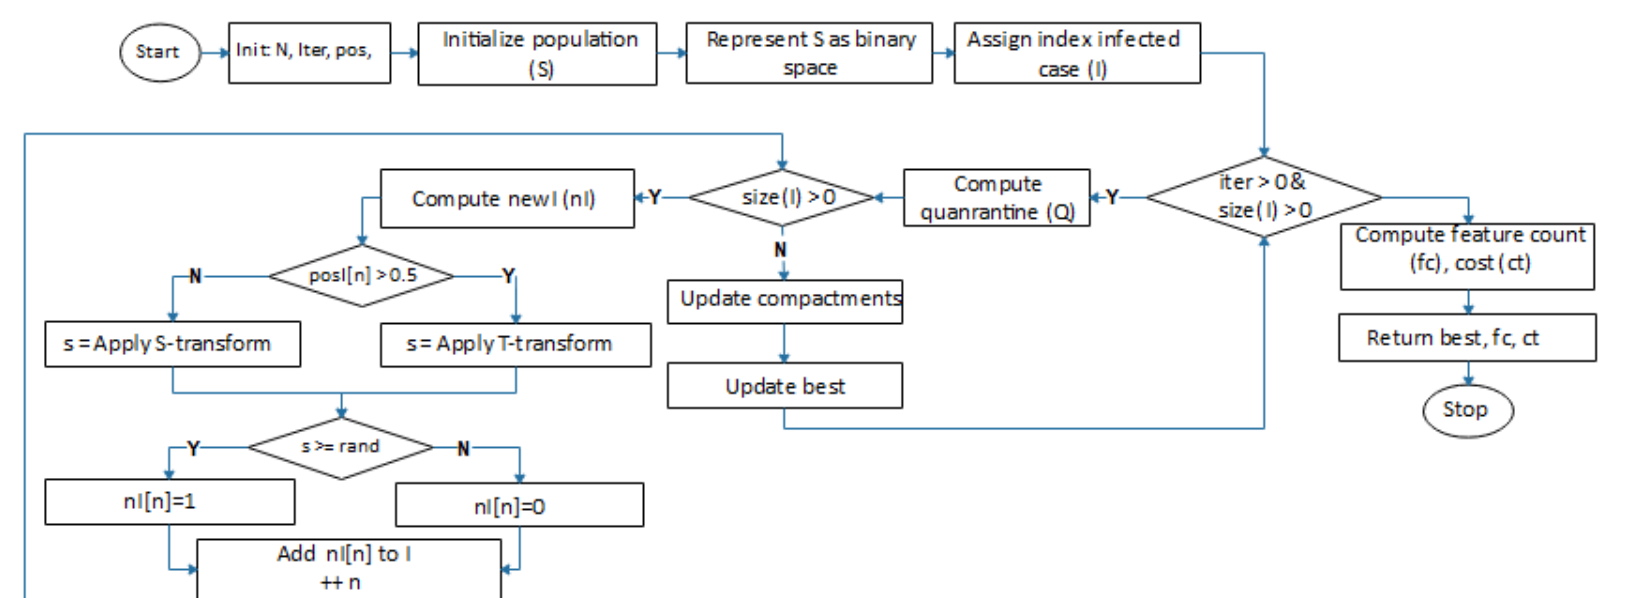
Figure 5. Flowchart of the BEOSA algorithm showing the application of the V-functions and S-functions to transform the feature indicators of individuals in the infected sub-population.